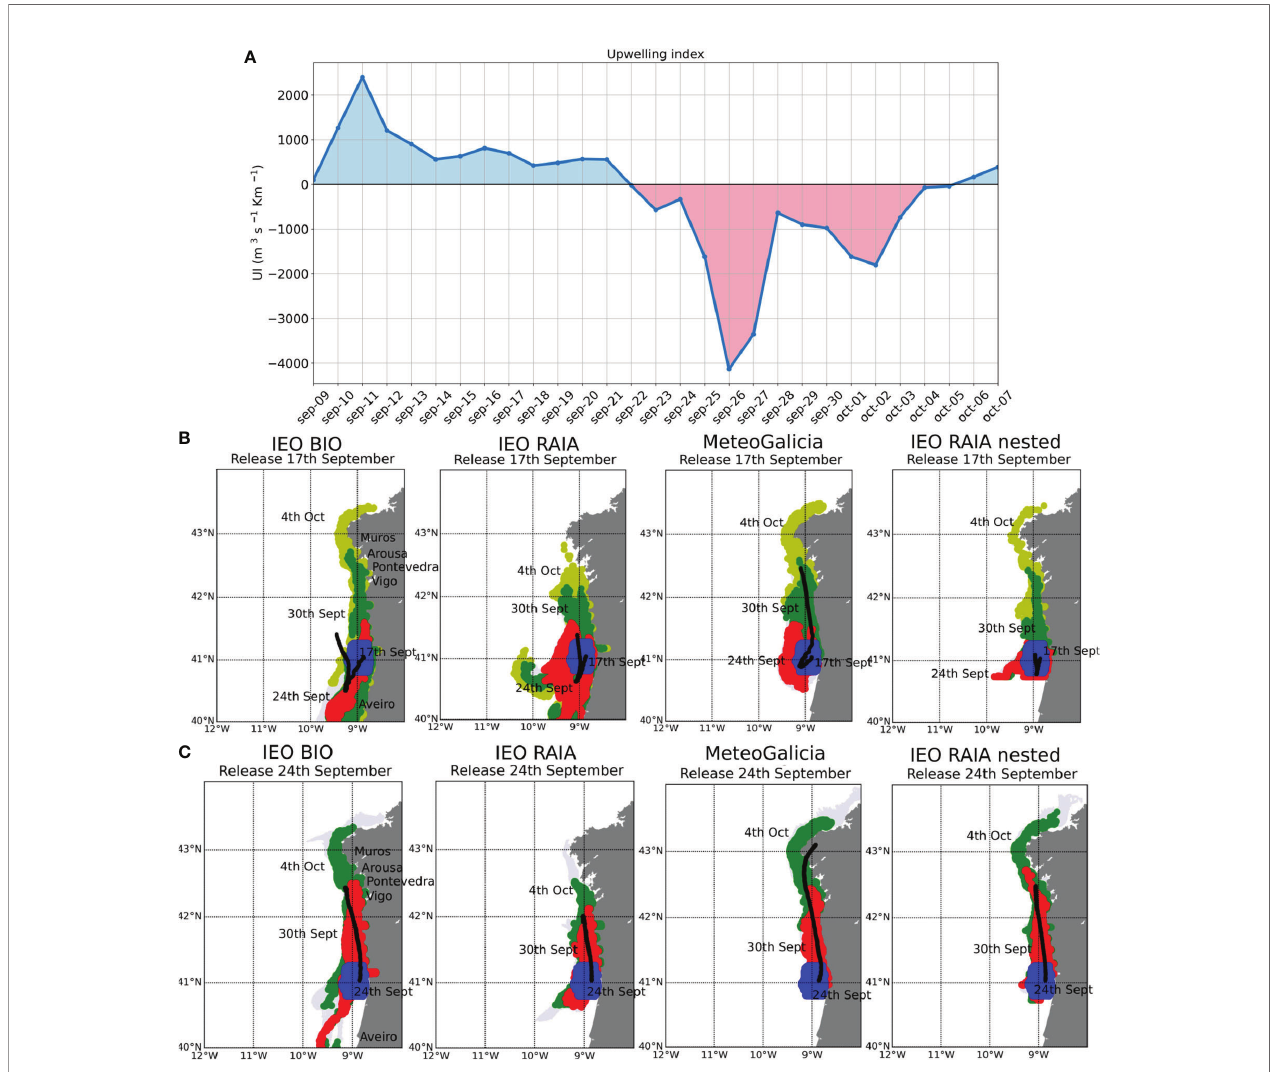
FIGURE 6 | Upwelling index for the September 2013 hindcast (A) . Particle positions at different dates after being released in different areas on the 17 th of September (B) and on the 24 th of September (C) . Black lines mark the trajectories of the Center of Gravity (CG). Column 1: IEO BIO model, 3.5 km resolution; Column 2: IEO RAIA model, 4 km resolution; Column 3: MeteoGalicia model, 2 km resolution and Column 4: IEO RAIA nested model, 1 km resolution. TABLE 2 | Sequence of events: D. acuta event 2013 and D. acuta and D. acuminata event 2020 at Portugal and Galician Rias.